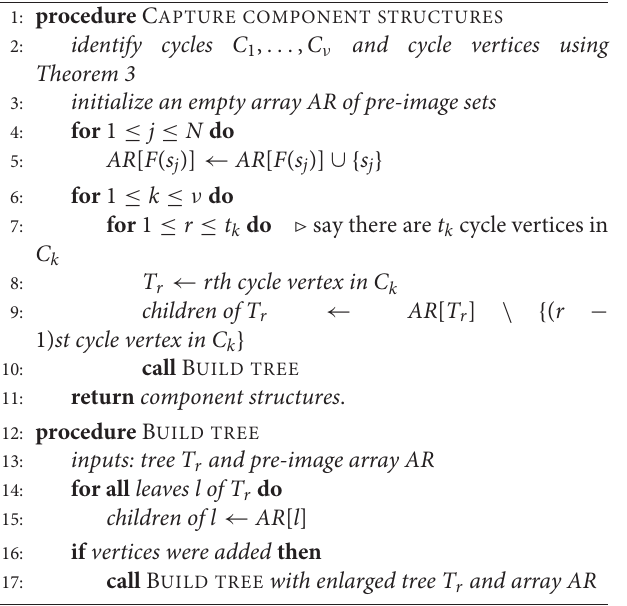
Algorithm 1 Identify cycles and in-trees for function